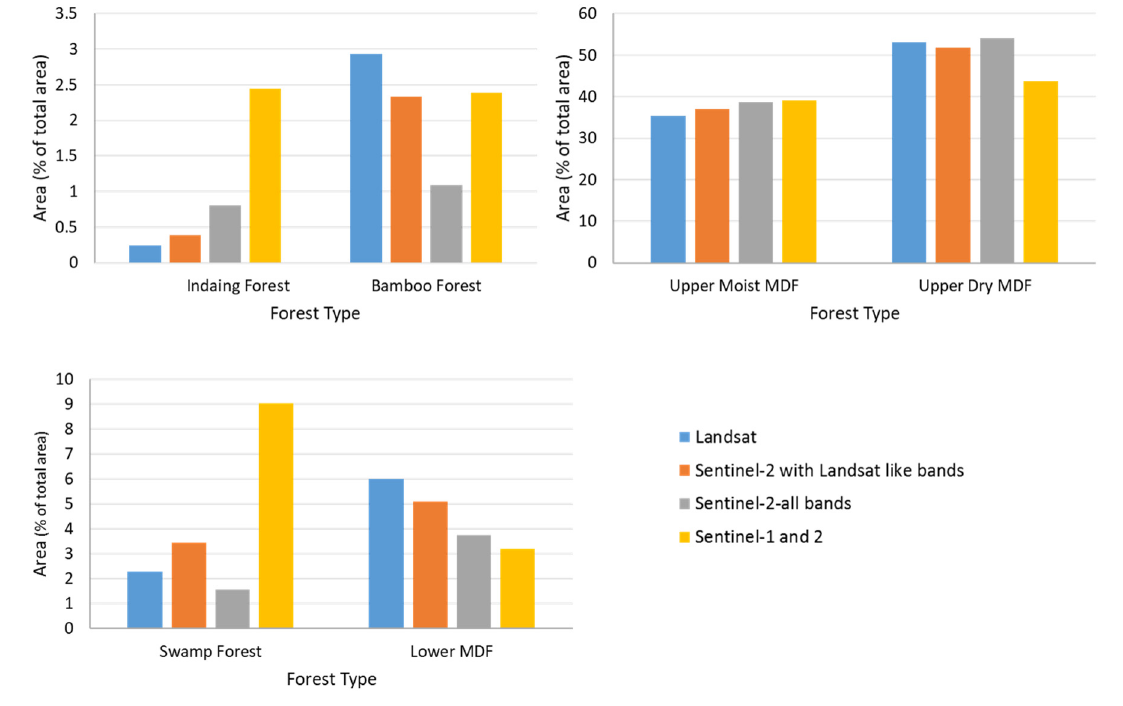
Figure 3. Variation in percent area estimates for different forest types in the Bago Region of Myanmar. We are comparing different sets of spectral and textual variables from a range of satellite sensors. MDF: Mixed Deciduous Forest.